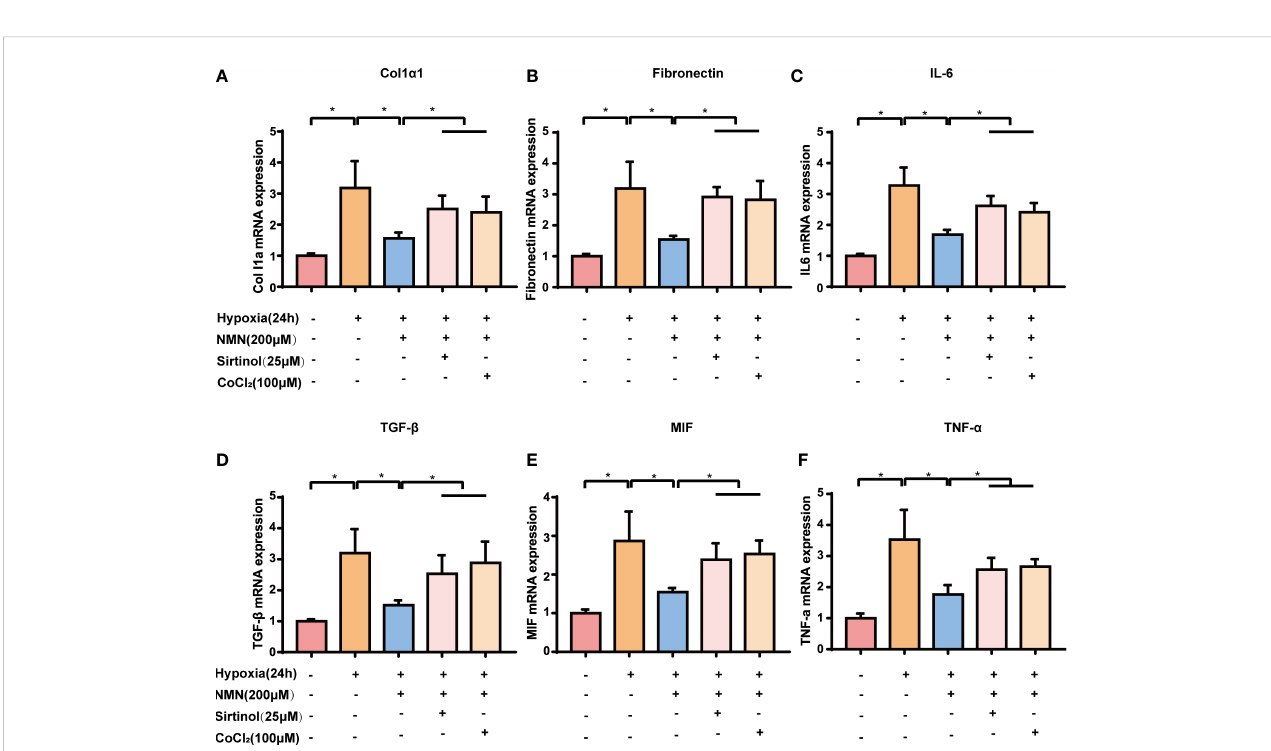
FIGURE 5 NMN suppresses HIF-1 a signalling-associated upregulation of fi brogenic and in fl ammatory gene in a SIRT1-dependent manner. (A – F) The relative mRNA levels of Col1 a , Fibronectin, IL-6, TGF- b , MIF and TNF- a normalized to b -actin in SVF cells (n = 3). * P < 0.05 versus control group, # P < 0.05 versus hypoxia